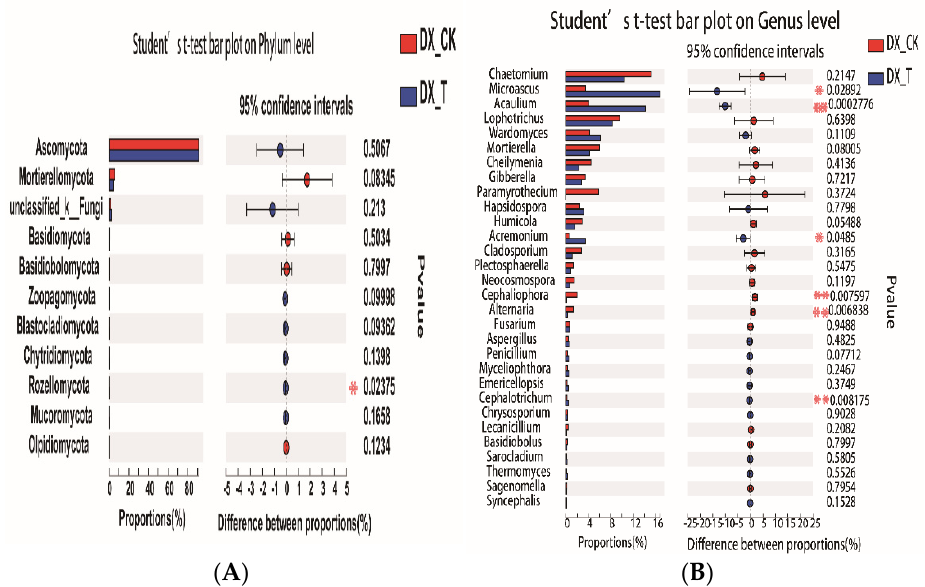
Figure 12. Changes in the relative abundance of fungal ( A ) phyla and ( B ) genera in triple-fumigated soil that had been used to produce watermelon. ‘Triple fumigation’ refers to the simultaneous application of chloropicrin, dimethyl disulfide and metham sodium. The t -test reported the statistical differences (asterisked, * 0.01 < p ≤ 0.05; ** 0.001 < p ≤ 0.01; *** p ≤ 0.001) between the means of three replicates within the phylum or genus levels.